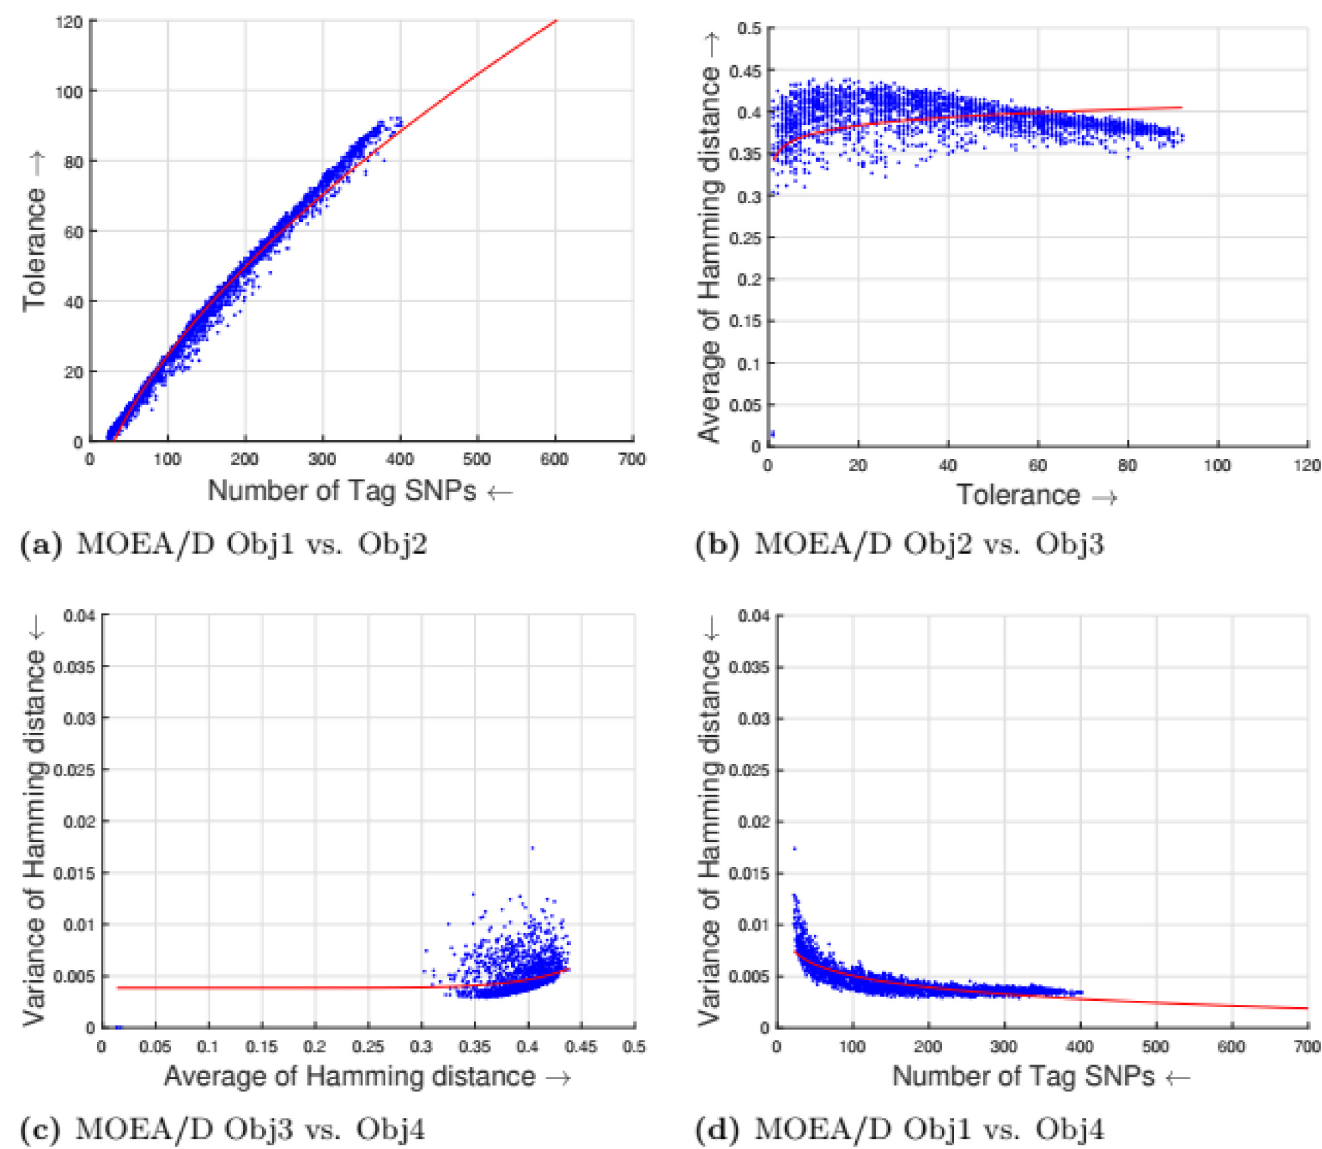
Fig 8. Experimental results of MOEA/D using greedy initialization for the tag SNPs selection problem. Obj1 stands for the number of tag SNPs, Obj2 is the tolerance for missing data, Obj3 measures the average Hamming distance between alleles, and Obj4 controls the variance of detection power in each allele. (a) MOEA/ D Obj1 vs. Obj2, (b) MOEA/D Obj2 vs. Obj3, (c) MOEA/D Obj3 vs. Obj4, (b) MOEA/D Obj1 vs. Obj4.